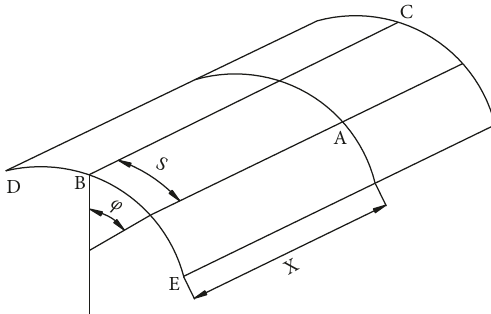
Figure 4: Geometric graph of the curved surface of the shell.